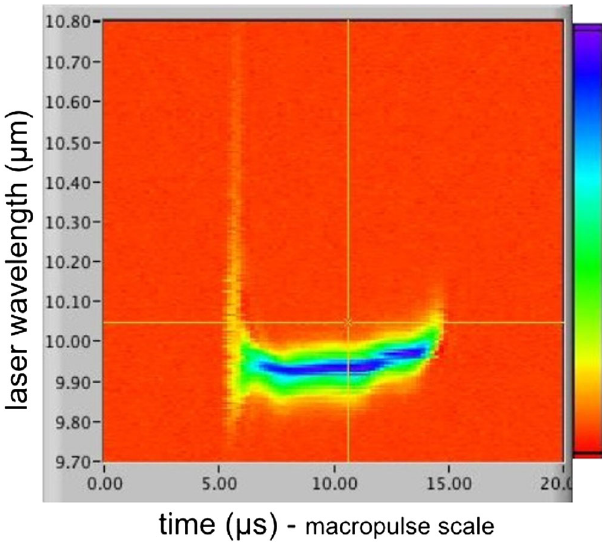
FIG. 4. Power spectrum of the CLIO laser vs time, at the macropulse